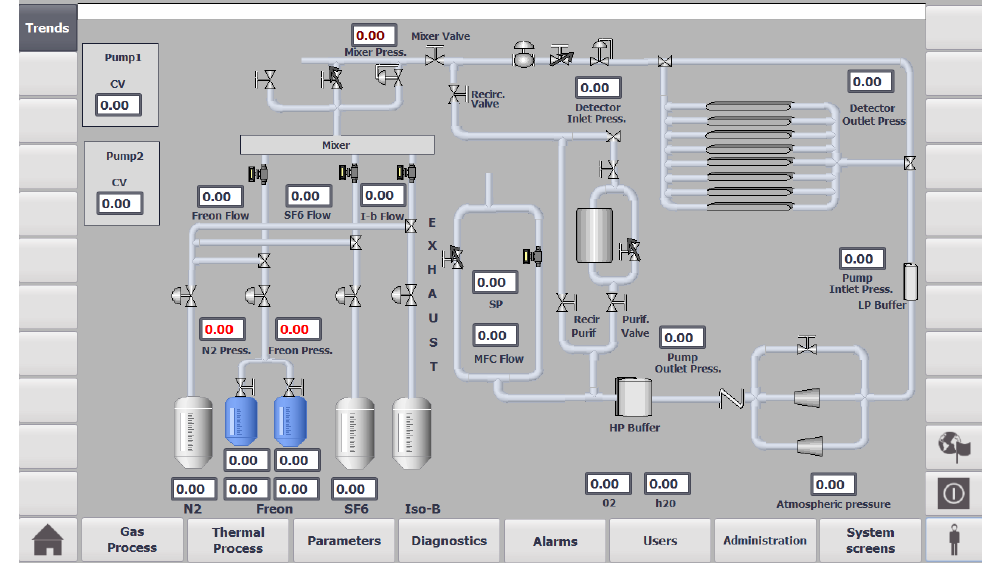
Figure 9. The digital twin SCADA gas process main operators